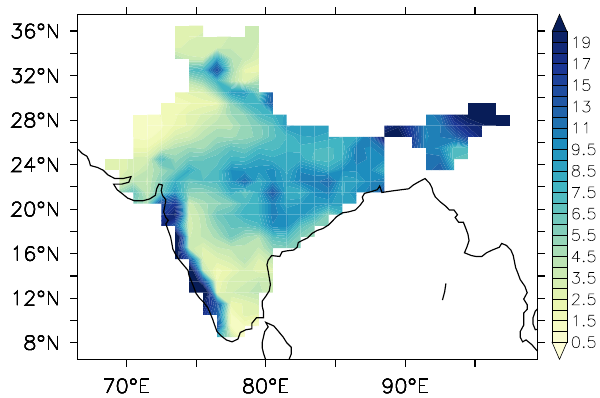
Fig. 2. June–September (JJAS) rainfall climatology (mm/day) dur- ing the period 1970–2000 from the India Meteorological Depart- ment (IMD) daily gridded observational dataset. Mean precipita- tion is highest over south-west peninsular India, north-east India and central